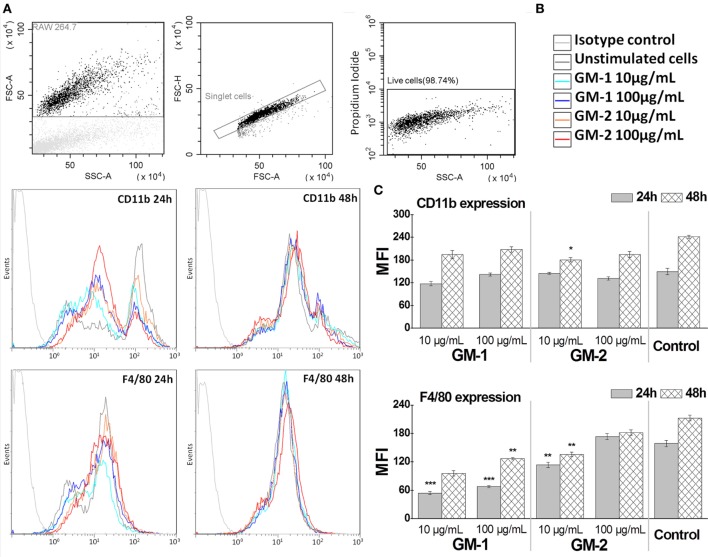
Immunocytometric measurement of RAW264.7 macrophage cell-line expression of major cell surface antigens F4/80 and CD11b following of the treatment by glycoconjugates GM-1 or GM-2 at 10 or 100 µg/mL concentrations. Gates were set to exclude the cellular debris using forward scatter vs. side scatter dot plot discrimination, doublets and dead cells (A). The settings were optimized using proper isotype control. Fluorescence histograms (B) of 10,000 cells were generated and analyzed (green fluorescence, 525-nm band-pass filter). The data (C) are expressed as a mean of fluorescence intensity. The statistical significance of differences between untreated cells (Control) and stimulated cells using one-way ANOVA and post hoc Bonferroni’s tests is expressed as follows: ***—P < 0.001, **—0.001 < P < 0.01, *—0.01 < P < 0.05.